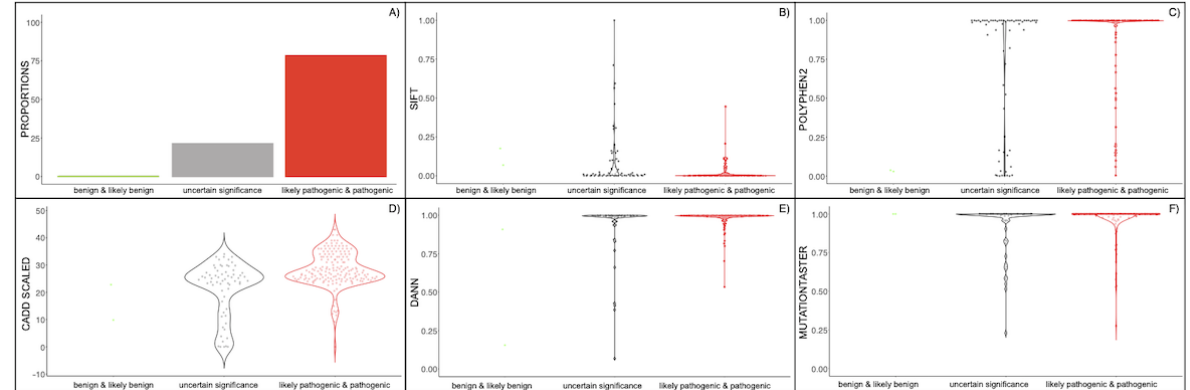
Figure 3. Precalculated pathogenic scores by the American College of Medical Genetics and Genomics (ACMG) pathogenic class for variants affecting function recorded in HADA. Panel A: VarSome proportions of ACMG classes among the hereditary angioedema variants affecting function. Panels B–F: pathogenicity prediction scores by ACMG pathogenic classes as provided by